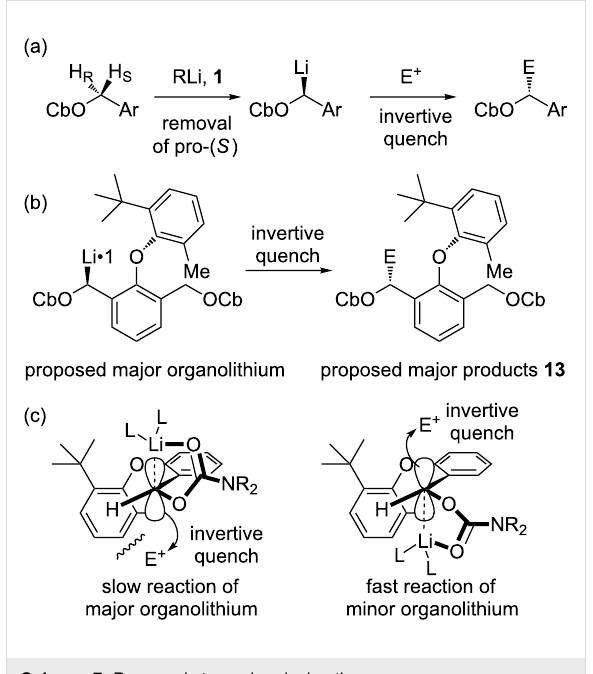
(Table 1), and the effect of ( − )-sparteine on the d.r.'s in Table